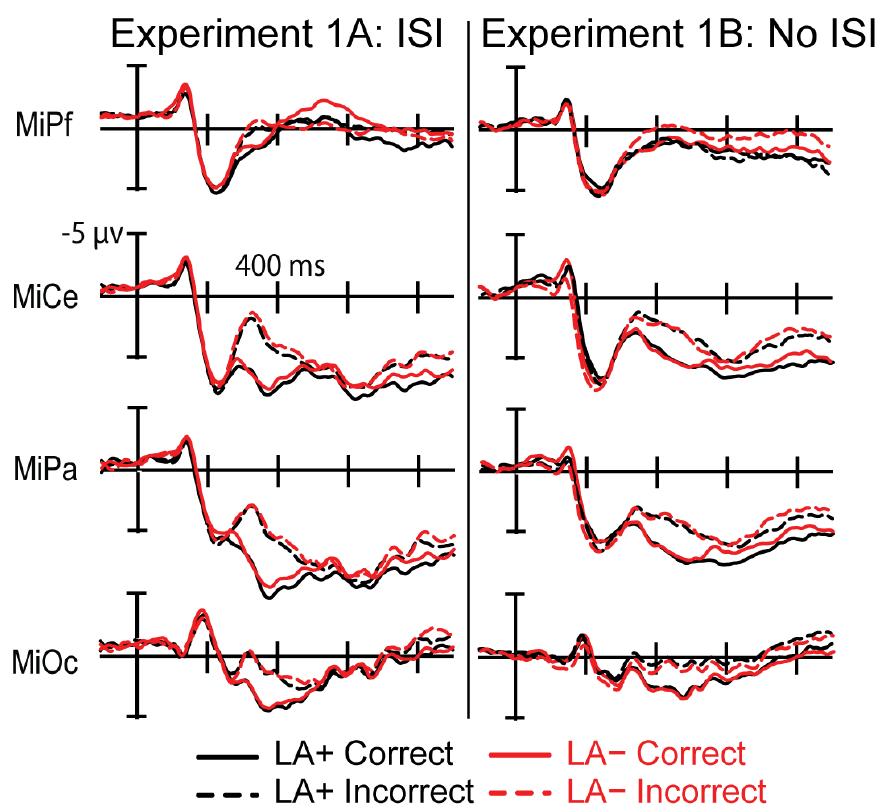
Figure 5. Grand averaged ERPs time-locked to Arabic digit solution onset for multiplication problems presented as spoken number words in LA+ (black) and spoken number words in LA − (red) with and without interstimulus intervals (ISIs) during the presentation of the problem. Representative midline electrodes are shown. Responses to correct solutions are represented as solid lines and responses to incorrect solutions are represented as dotted lines.